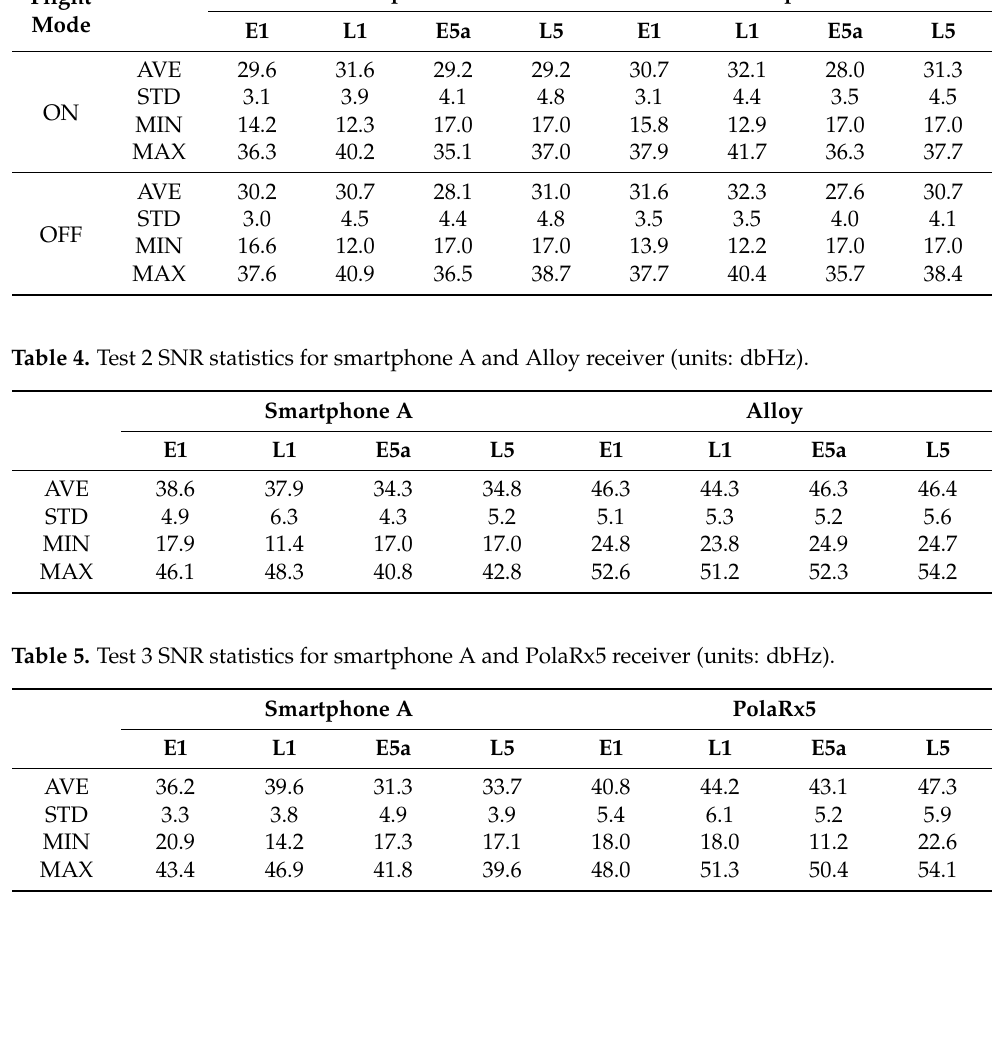
Table 3. Test 1 SNR statistics for smartphone A and B (units: dbHz). Flight